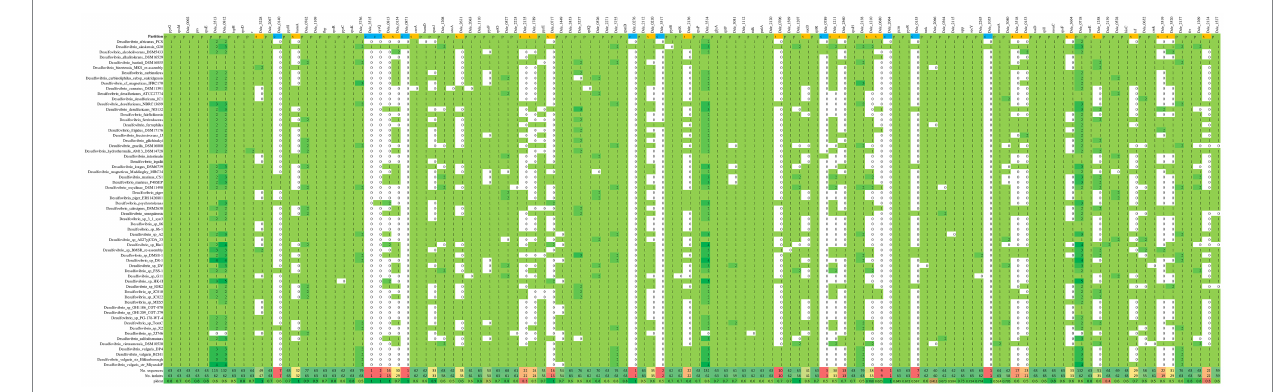
FIGURE 6 Heatmap showing the presence-absence matrix for all the conserved genes across the 63 different Desulfovibrio genomes. The vertical columns denote the enriched genes, and the horizontal rows denotes the Desulfovibrio genomes. The green and the white background denotes the presence and absence of the enriched genes in corresponding genome,